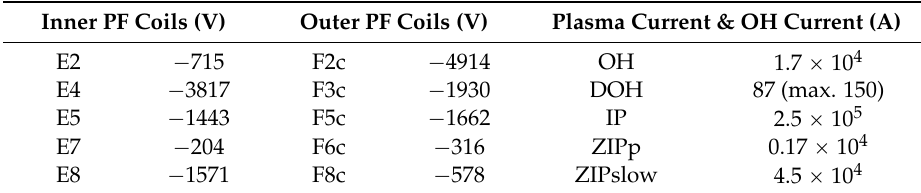
Table 1. TCV relevant